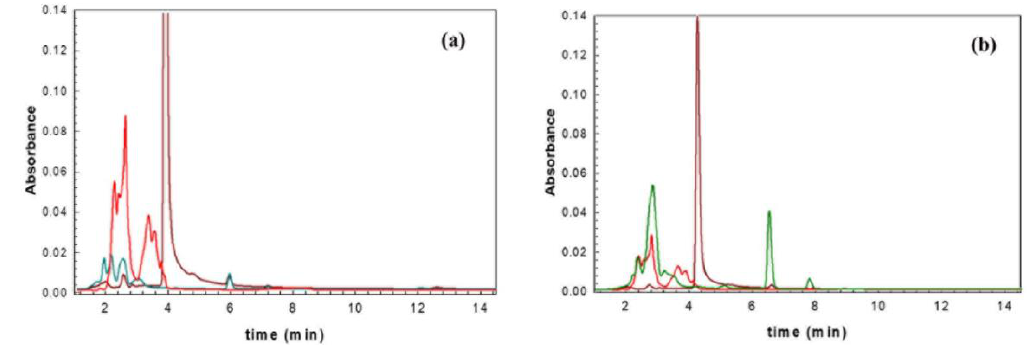
Figure 1. Superposition of quercetin (brown) and myricetin (red) signals with those of FC-B ( a ) and FC-A ( b ) samples.